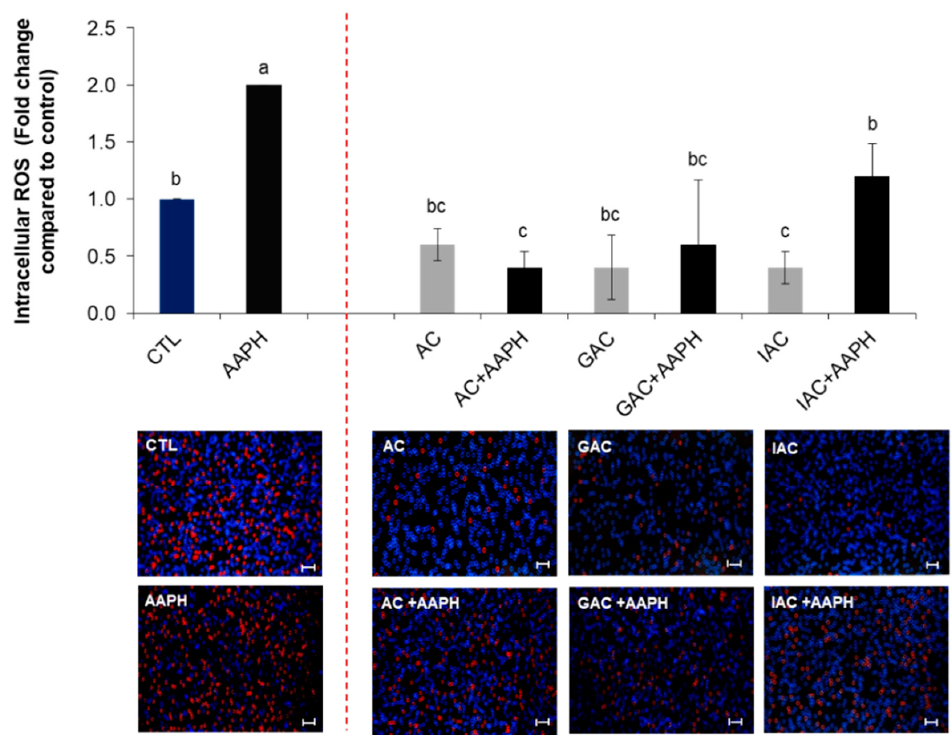
Figure 5. Intracellular reactive oxygen species (ROS) accumulation in HepG2 cells determined by the Tali ® Image-Based Cytometer. Cells were preincubated with the indicated achene fractions and then stressed with AAPH for 24 h. Values are expressed as the mean ± SD of three independent experiments ( n = 3). Columns belonging to the same set of data with different superscript letters are significantly different ( p < 0.05). Representative images of intracellular ROS quantification are shown following the graphs (stressed cells appear red). Scale bar: 50 µm. CTL: cells without treatment; AC: cells incubated with the achene; GAC: cells incubated with achene after gastric digestion; IAC: cells incubated with achene after intestinal digestion; AAPH: cells incubated with AAPH; AC + AAPH: cells preincubated with the achene and then stressed with AAPH; GAC+AAPH: cells preincubated with achene after gastric digestion and then stressed with AAPH; IAC + AAPH: cells preincubated